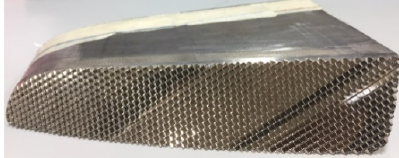
Figure 17. The SuperPin Plus curved CCR sample—output of the optimized design.